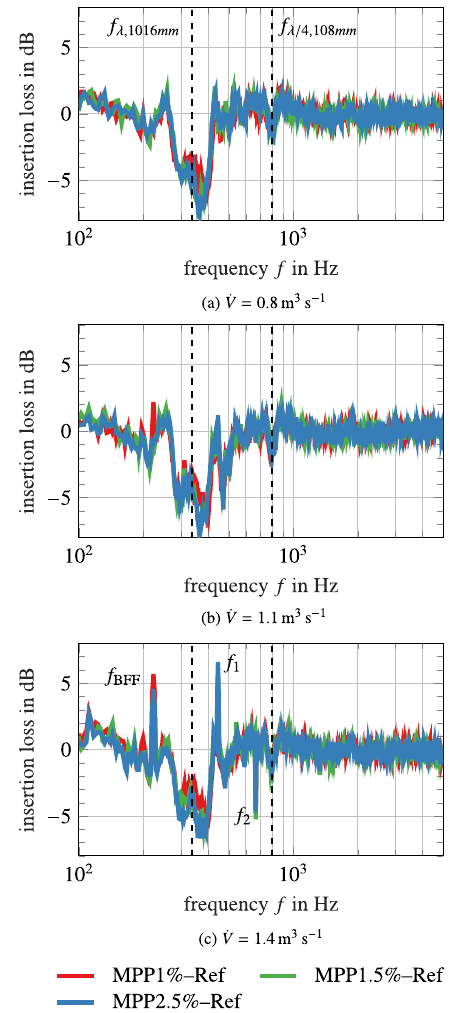
Figure 4. Insertion loss between the modi fi ed heat exchangers with MPA and the unmodi fi ed reference heat exchanger (rigid walls and without cavity) at different operating